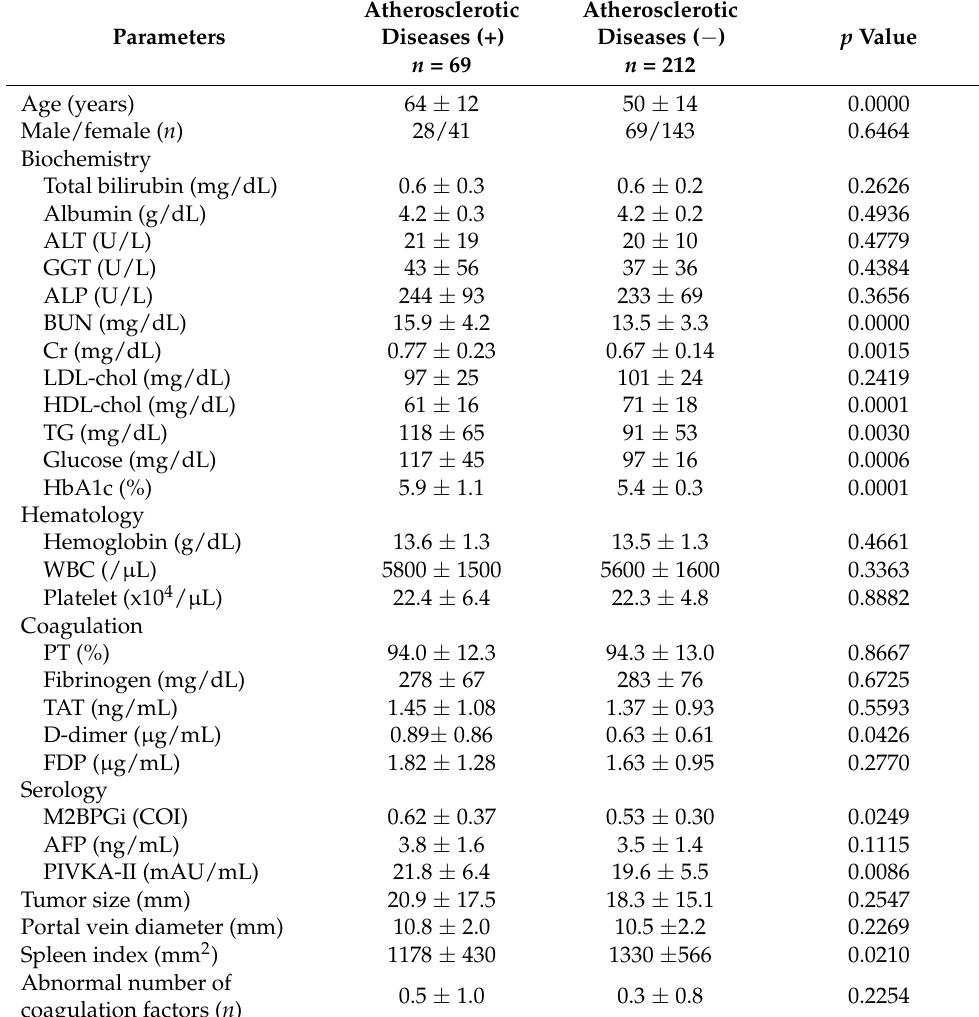
Table 8. Comparison of clinical parameters in patients with and without atherosclerotic disease *.